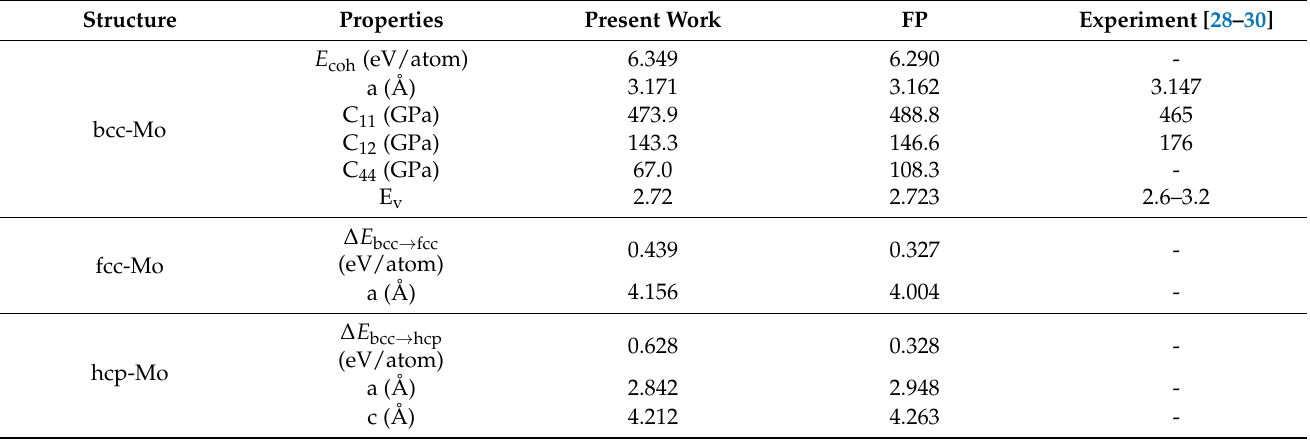
Table 3. Reproduced values of lattice constants, cohesive energies, and elastic constants of pure molybdenum. Structure